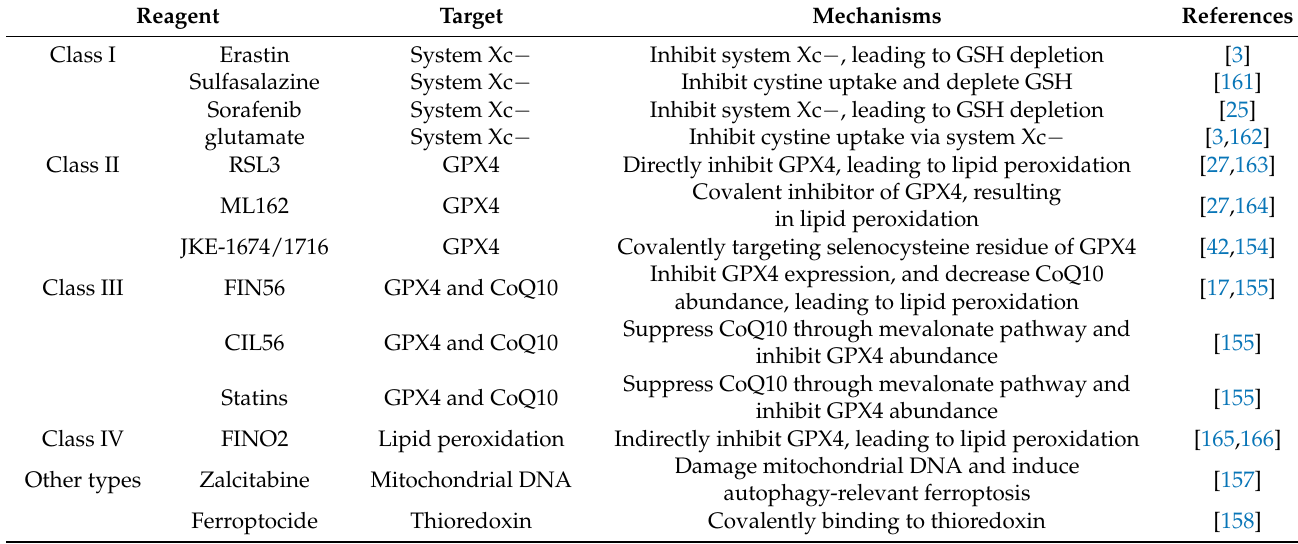
Table 1. Major Inducers of Ferroptosis.